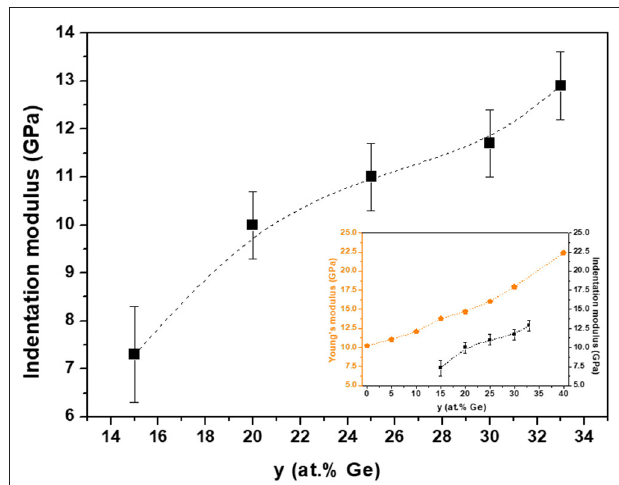
FIGURE 1 | Indentation moduli for bulk Ge y Se 100 − y glasses. Insert shows the comparison between Young’s modulus (Guin et al., 2002) and indentation modulus obtained by PF-QNM measurements. The broken lines are drawn as guides for the eye. The indentation modulus values and the error bars were calculated from an average of three PF-QNM measurements and standard deviation